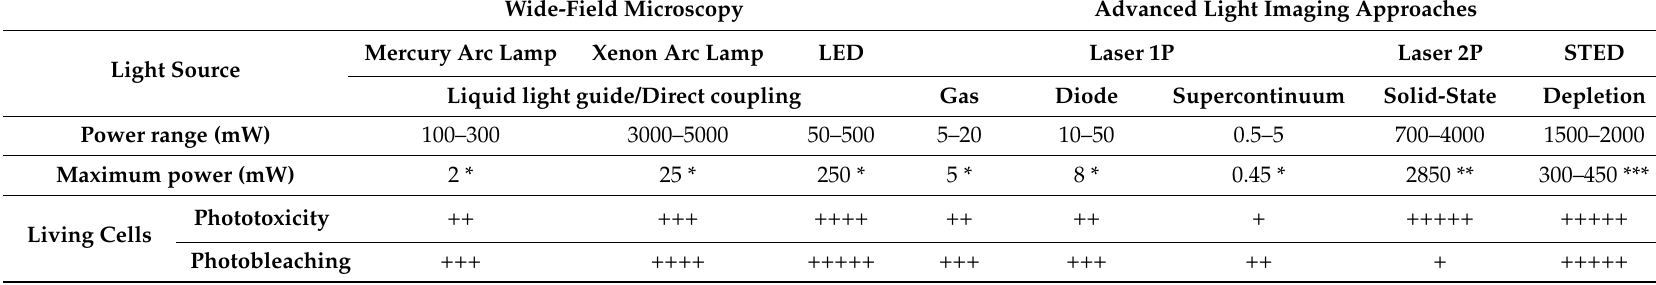
Table 2. Comparison of characteristics of light sources currently used for live cell imaging. Special focus has been given to phototoxicity and photobleaching induced by light